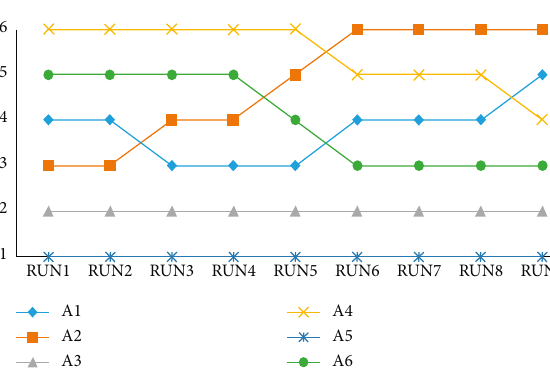
Figure 2: Line graph of sensitivity analysis results. Table 17: Comparison of six neutrosophic-based MCDM